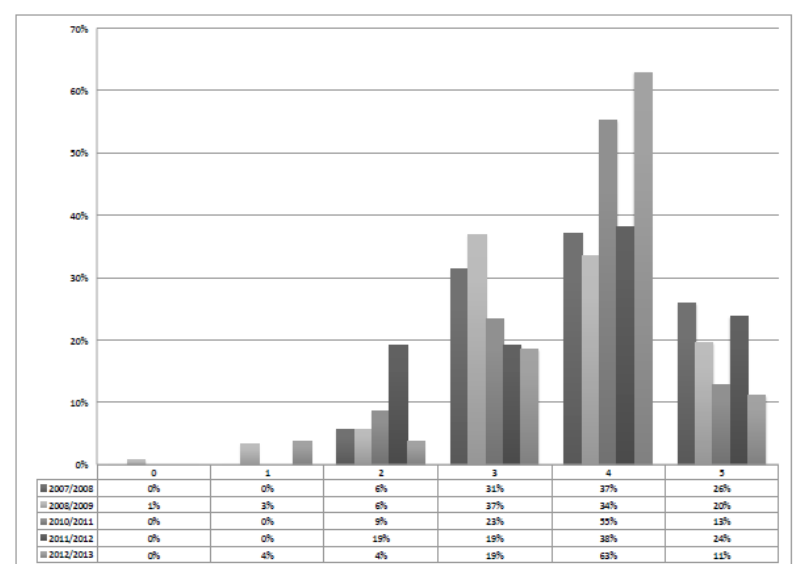
Figure 10. JavaVis is a tool easy to